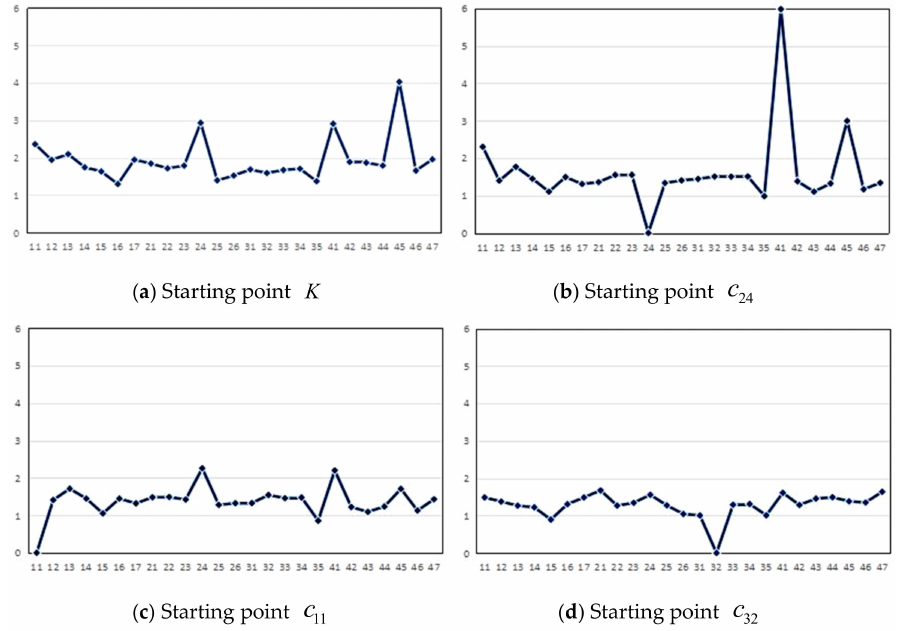
Figure 5. The objective function fluctuating curves when searching seed tourist sites with di ff erent starting points. ( a ) The objective function fluctuating curve which starts searching from K ; ( b ) The objective function fluctuating curve which starts searching from c 24 ; ( c ) The objective function fluctuating curve which starts searching from c 11 ; and ( d ) The objective function fluctuating curve, which starts searching from c 32